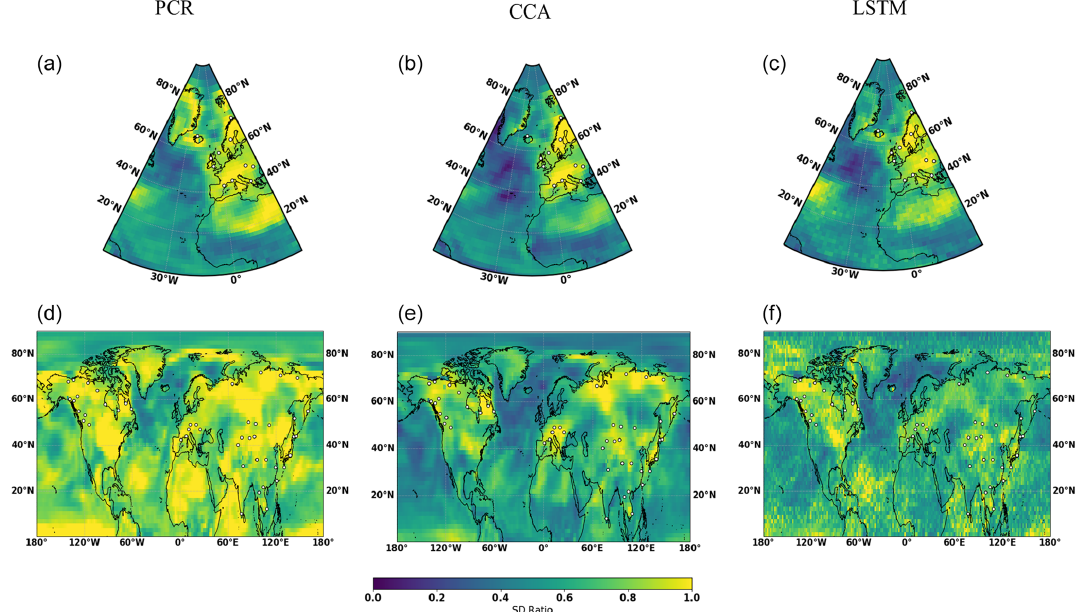
Figure C1. The 30-year filtered SD ratio pattern using ideal PPEs based on the MPI model over the validation period (850–1899CE) for the NAE (a–c) and NH (d–f)